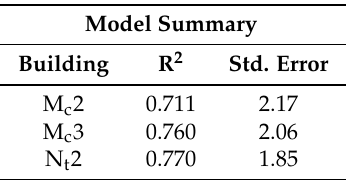
Table 5. Summary statistics for the PALM-GIS model for PM 2.5 .